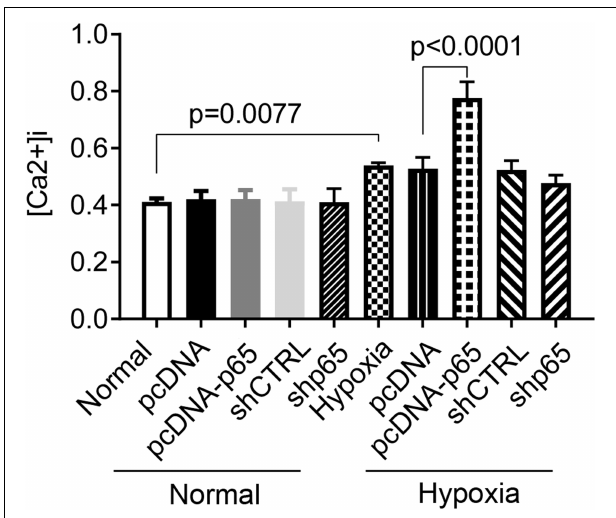
FIGURE 5 | Influence of hypoxia and the expression of p65 on the Ca 2 + influx. The differences were analyzed using one-way ANOVA. CTRL,